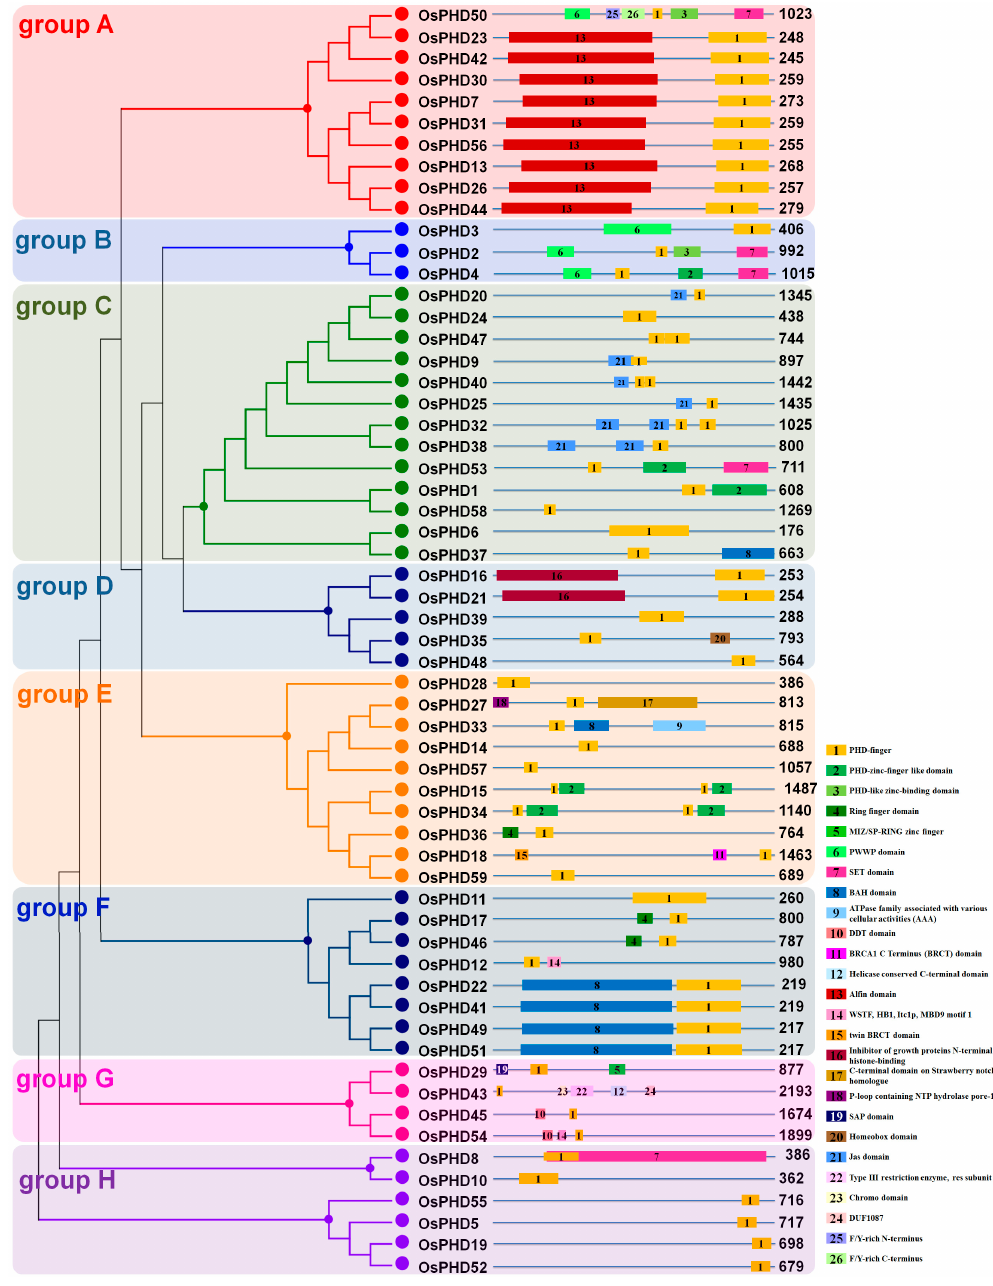
Figure 5. Functional domains of the rice PHD family proteins. The information on functional domains was obtained from the phytozome and is shown in the diagrams. Different colored boxes with numbers in them represent different functional domains.